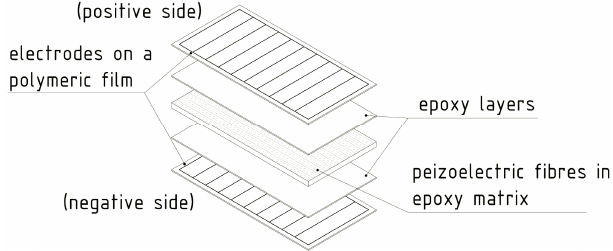
Figure 16. Generalised scheme of the structure of an MFC transducer.